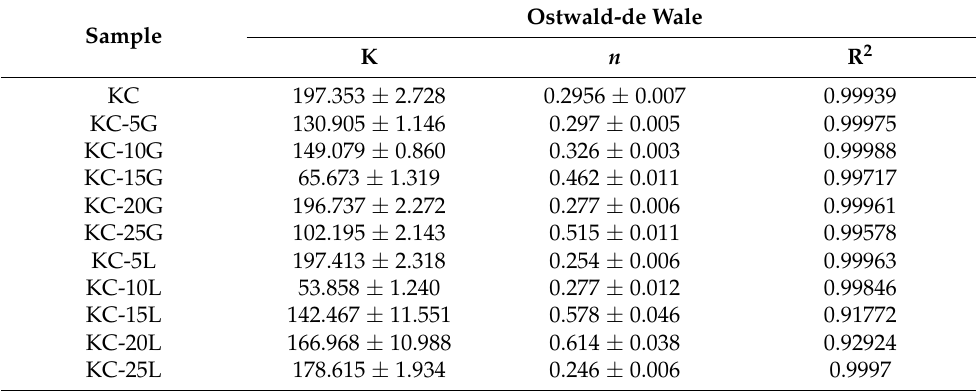
Table 4. The Ostwald–de Wale model parameters of the films.